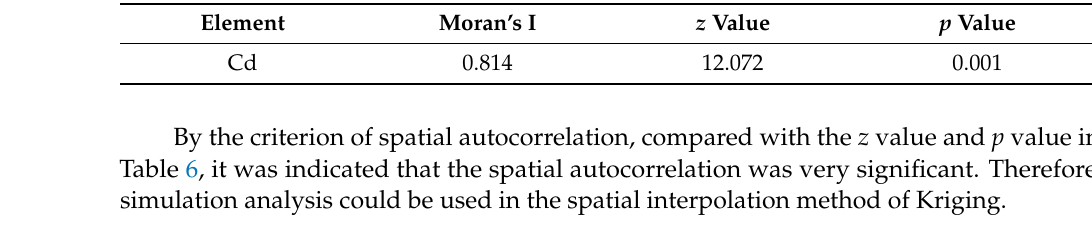
Table 6. Digital features of autocorrelation in data space.